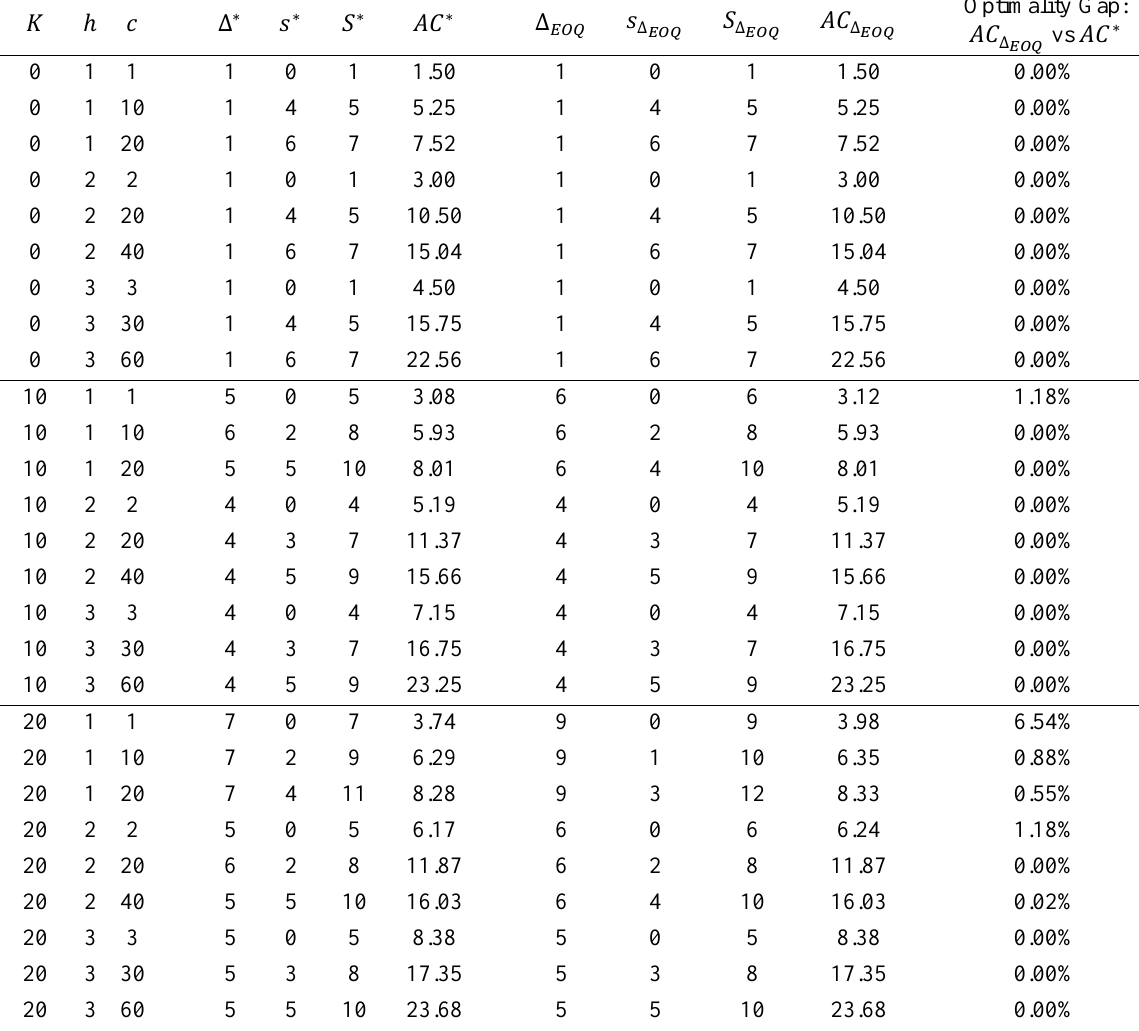
Table 7. Impact of system cost parameters for